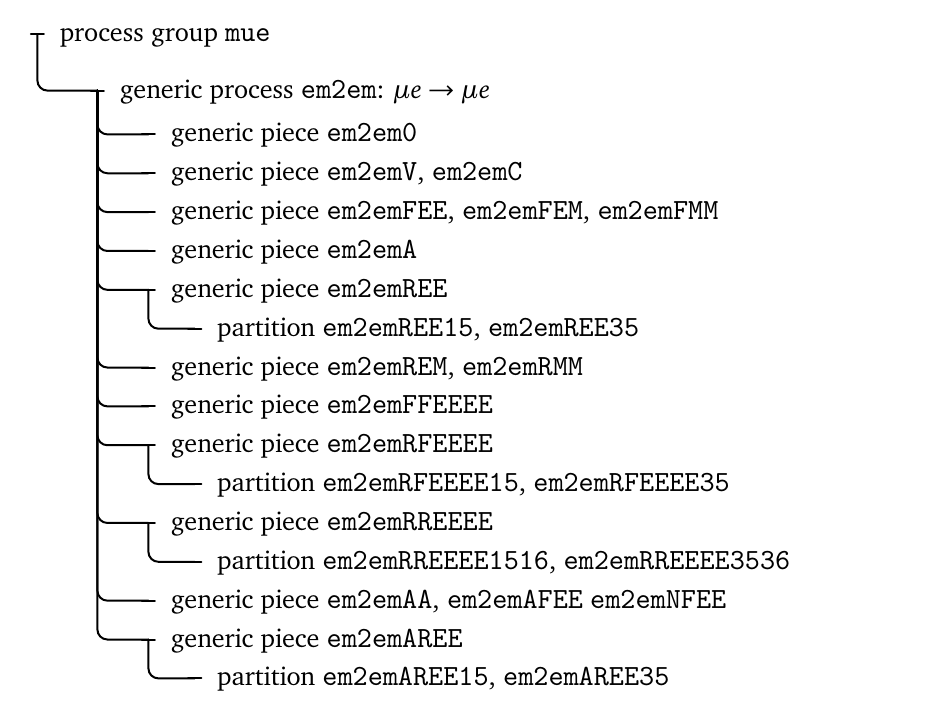
Figure 5: A complete list of contributions ( which_piece ) currently implemented for µ - e scattering. This is a subset of Figure